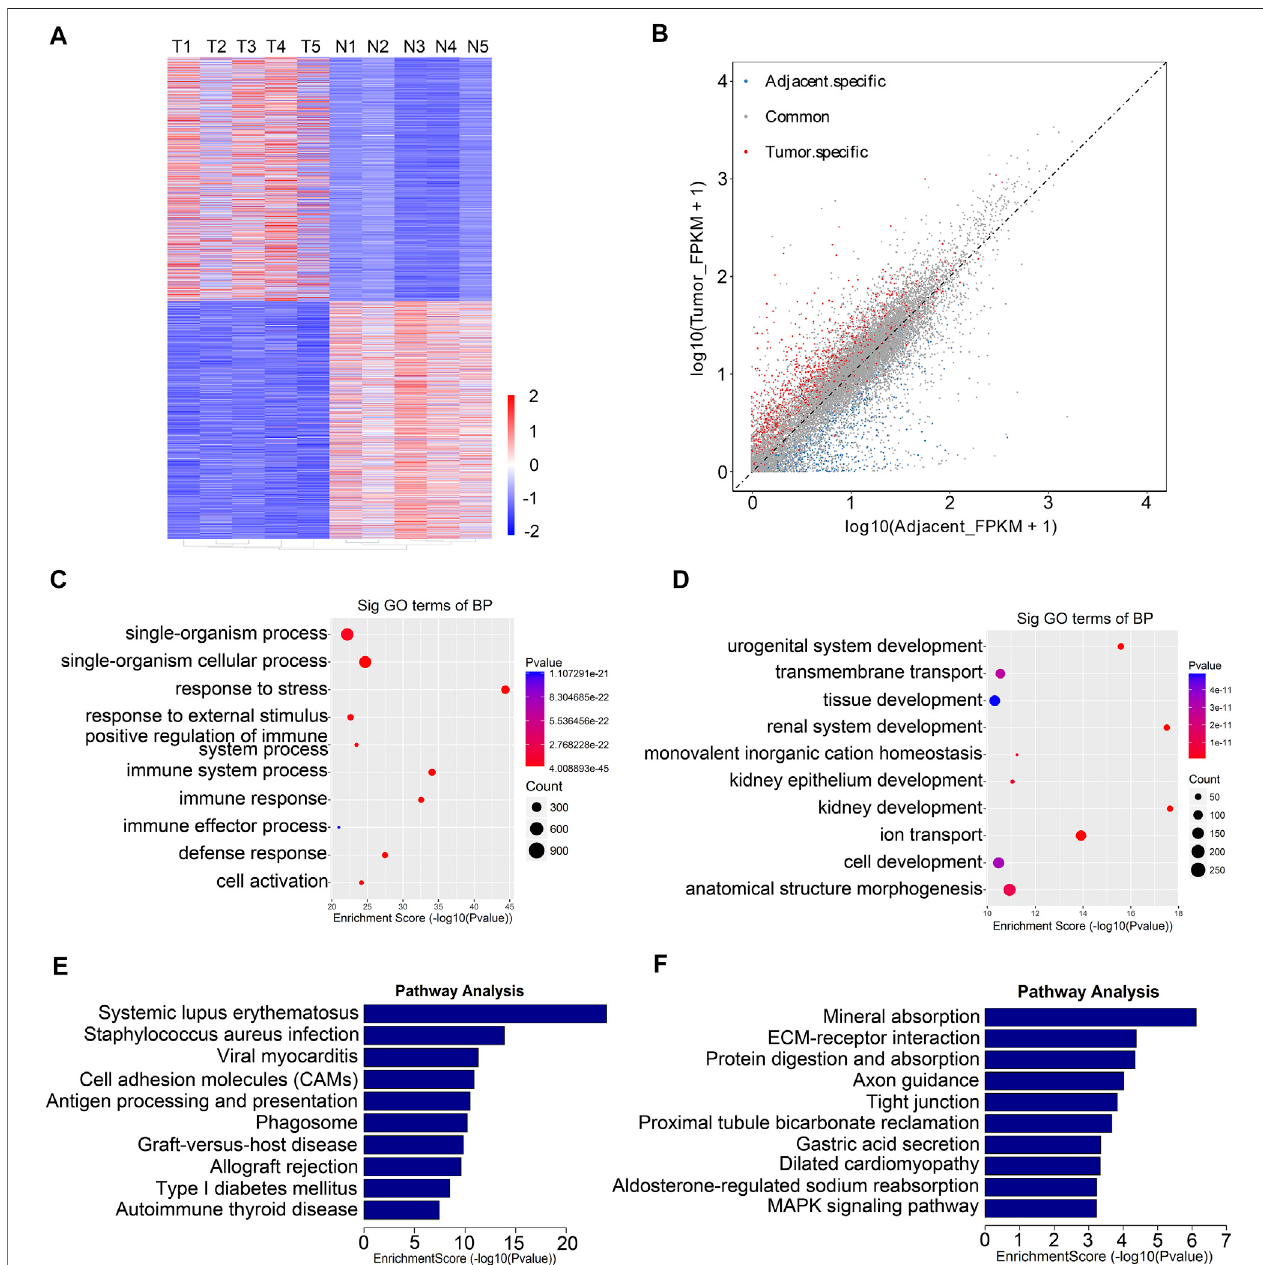
FIGURE 4 | Functional analysis of differentially expressed genes between fi ve paired renal tumor and adjacent tissues. (A) Heatmap of differentially expressed mRNAsinrenal tumor tissues and adjacenttissues (T, tumor group; N, adjacent normal group). (B) Scatter plotsshowing thetissue speci fi cDEGs (fold changes ≥ 2and p < 0.05). (C) GOanalysisofupregulated genesinRCCtumortissues. (D) GOanalysisofdownregulatedgenesinRCCtumortissues. (E) KEGGanalysisofupregulated genes in RCC tumor tissues. (F) KEGG analysis of downregulated genes in RCC tumor